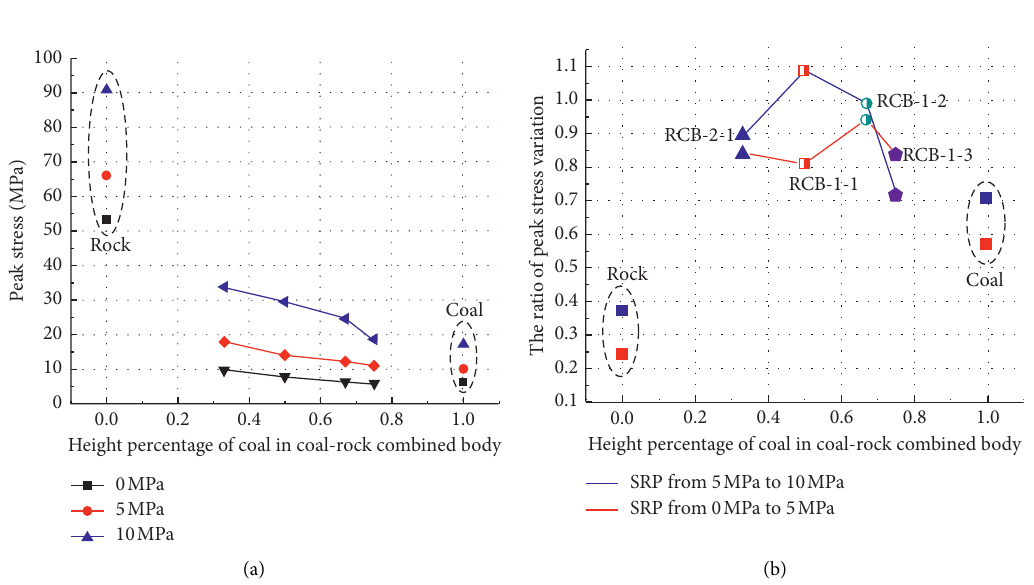
Figure 7: The relationship between the peak stress and its change value of coal-rock combination with δ under different confining pressures. (a) Changes in stress peaks with δ . (b) Changes in stress peaks at confining pressures from 0MPa to 5MPa and 5MPa to